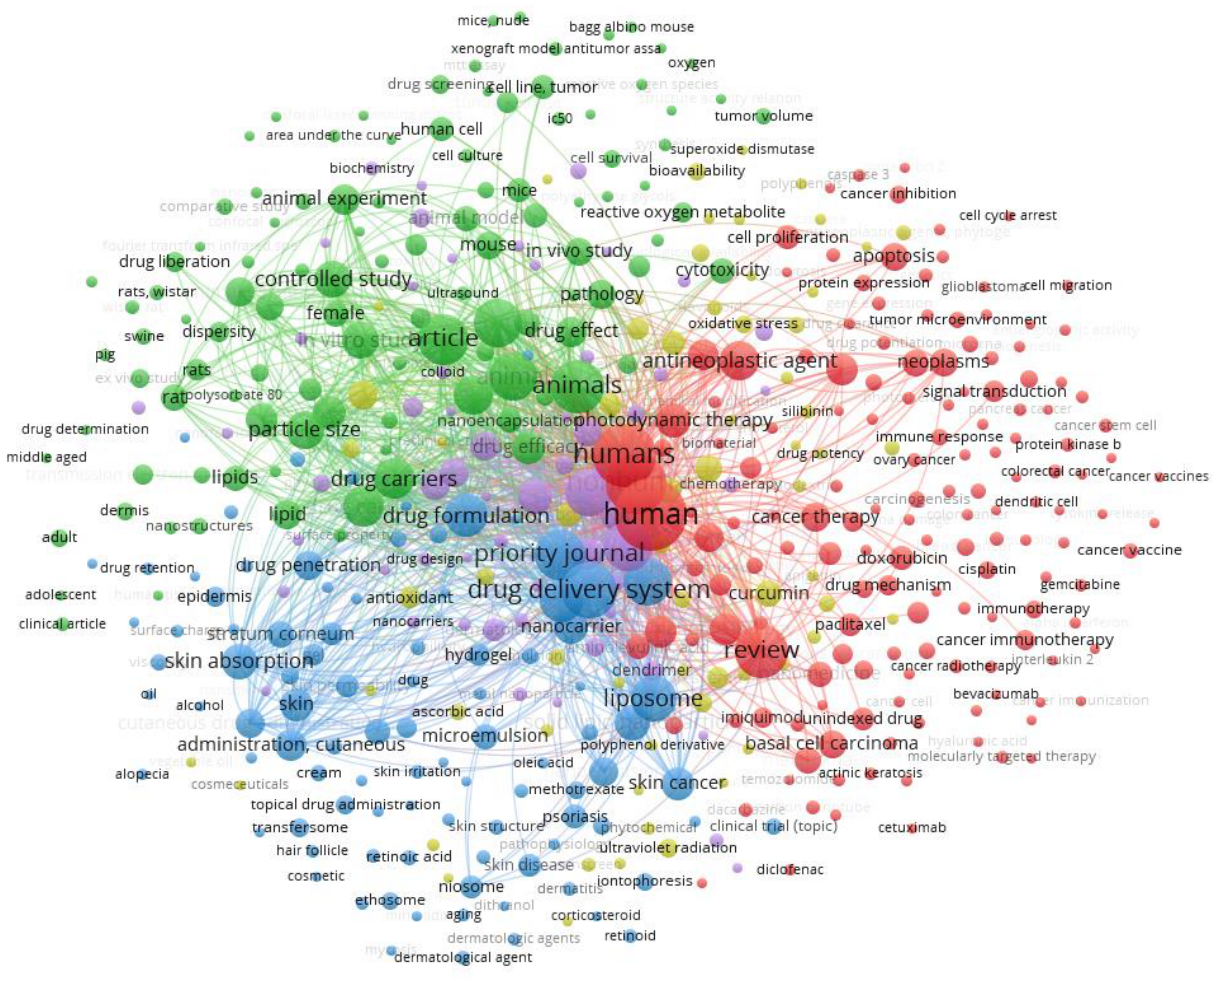
Figure 5. Bibliometric map generated by VOSviewer software [83] using “basal cell carcinoma” and “lipid nanoparticles” as keywords (from the Scopus database).